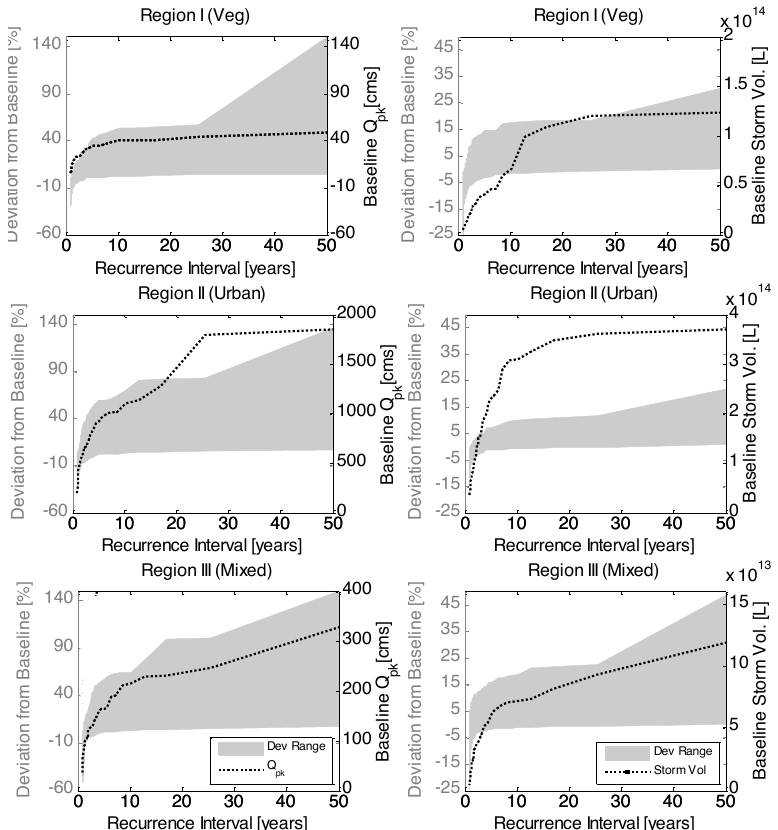
Fig. 6. Recurrence interval of peak discharge (left) and total storm volume (right) due to precipitation variability and temperature increase. Left axis corresponds to the range in percent deviation (shaded area) in peak discharge ( Q pk ) and storm volume due to precipitation vari- ability and temperature increase. Right axis corresponds to the baseline simulation of storm peak discharge and total storm volume (dotted